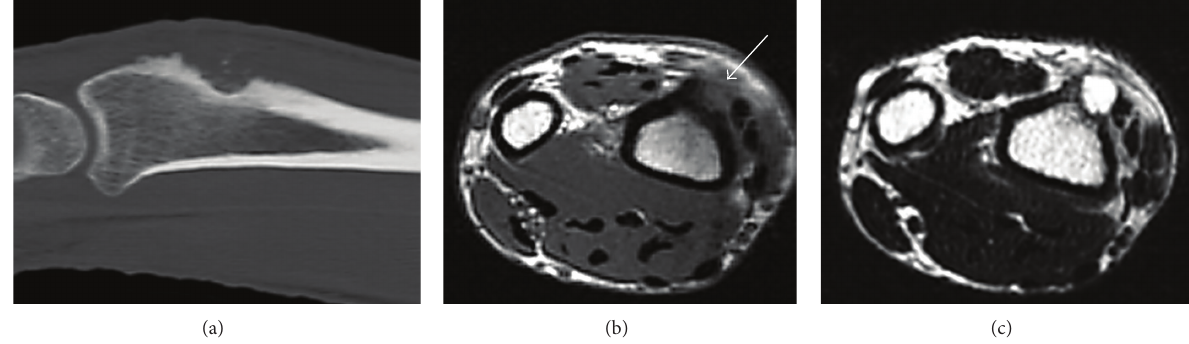
Figure 1: Imaging studies. (a) Sagittal CT-scan showing a lytic lesion on the dorsal cortex of the distal radius containing punctiform calcifications. ((b)-(c)) Axial MR images showing a soft tissue component (arrow) associated with the cortical lesion. Its appearance is isointense on T1 (b) and hyperintense on T2-weighted images (c).